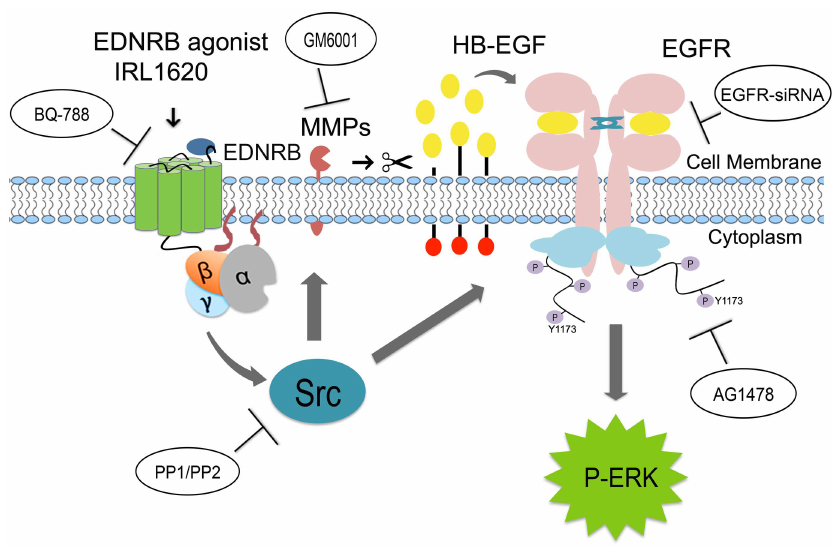
Fig 11. Illustration summarizing the EDNR signaling leading to transactivation of EGFR in Mu¨ller cells. Diagramshowingthe signal transduction events and inhibitorswith names within ellipsesthat were used to block the signalingsteps. Stimulation of EDNRB in Mu¨ller cells with EDNRB-agonist IRL1620that leads to activationof cytosolic Src kinase. The activated Src kinase triggers matrix-metalloproteinase (MMP), whose catalytic activity leads to releaseof membrane-boundheparin-bindingepidermalgrowth factor (HB-EGFR) and consequently causes ligand-dependent transactivation of the epidermalgrowth factor receptor(EGFR). Activated Src kinase may also trigger ligand-independentEGFR phosphorylation of tyrosine residue (Y1173). This transactivation leads to MAPK/ERK signaling in Mu¨ller cells that could be blockedby the EDNRB antagonist BQ-788, Src-kinase inhibitorsPP1 and PP2), EGFR-inhibitor AG1478, EGFR-small interfering RNA (EGFR-siRNA) or by the inhibitorGM6001, which inhibits extracellular matrix